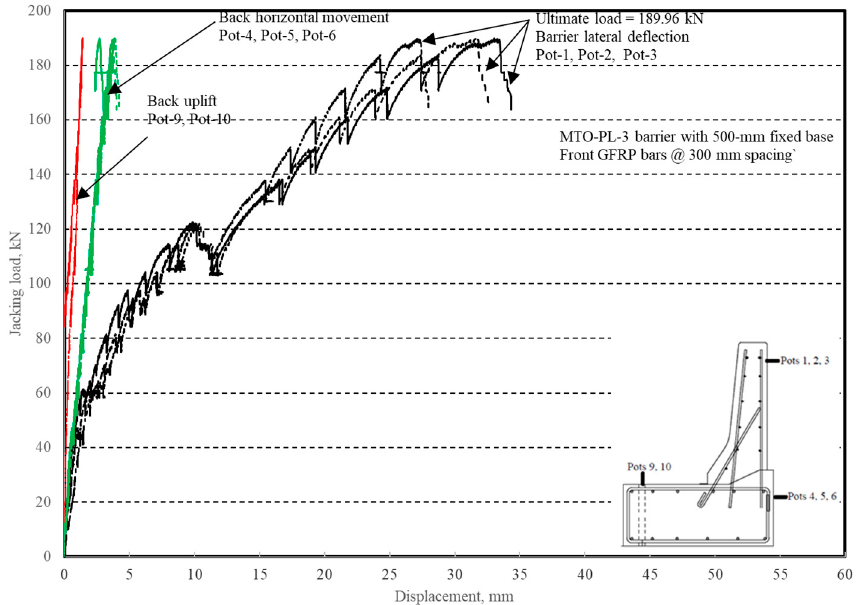
Figure 23. Specimen # 4: Load vs. displacement history.